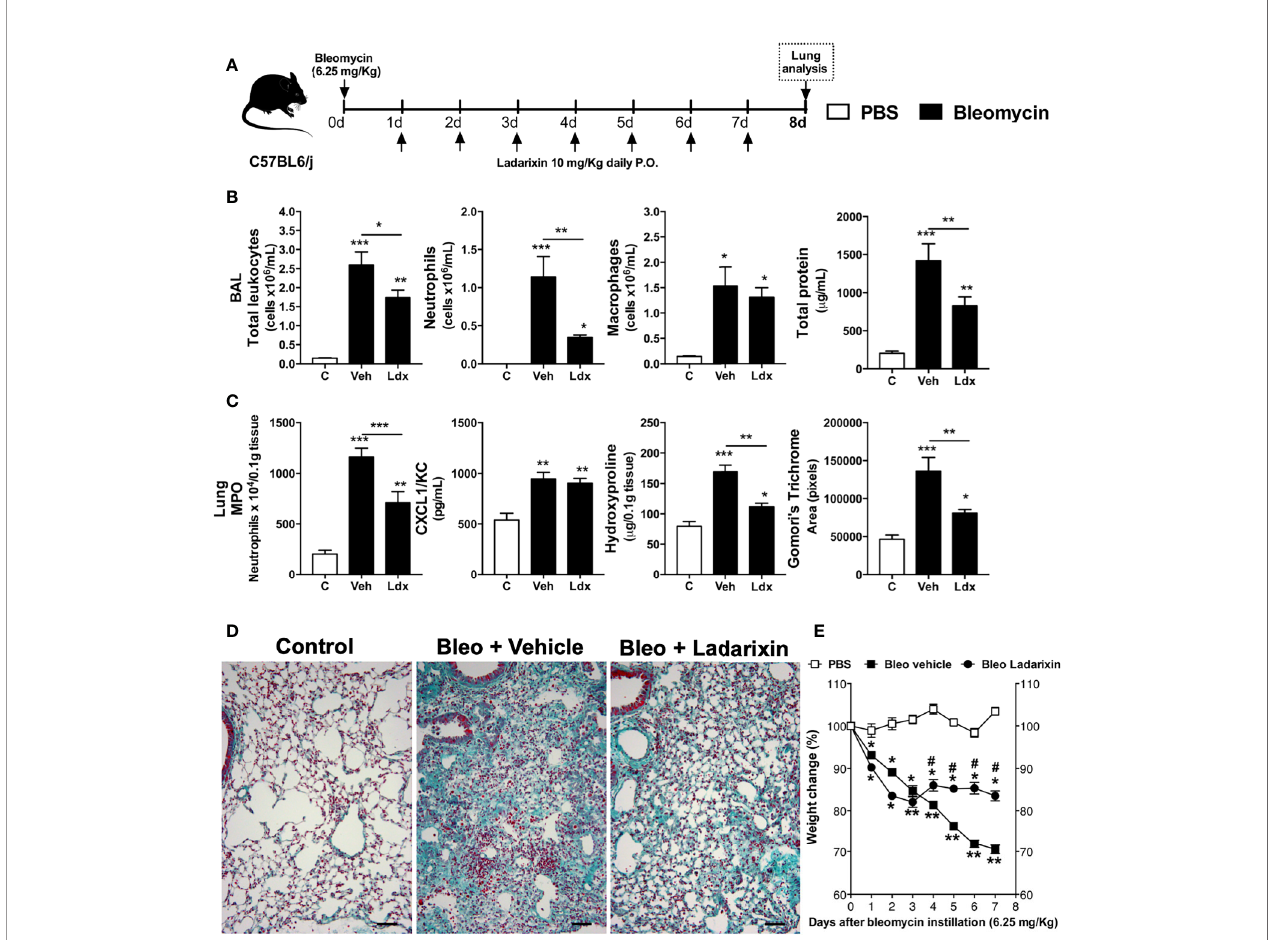
FIGURE 7 | Ladarixin treatment decreases fi brosis and airway in fl ammation in a Bleomycin-induced lung fi brosis model. (A) Schematic representation of the experimental design. (B) Assessment of leukocytes in fl ux and blood leakage into airways. (C) MPO activity quanti fi cation, CXCL1/KC levels and fi brosis assessment. (D) Histological sections of lungs (Gomori ’ s trichrome dye). (E) Mice weight change after Bleomycin instillation. n = 8 for each group, * for P < 0.05; ** for P < 0.01 and *** for p < 0.001. # differences between Ladarixin vs